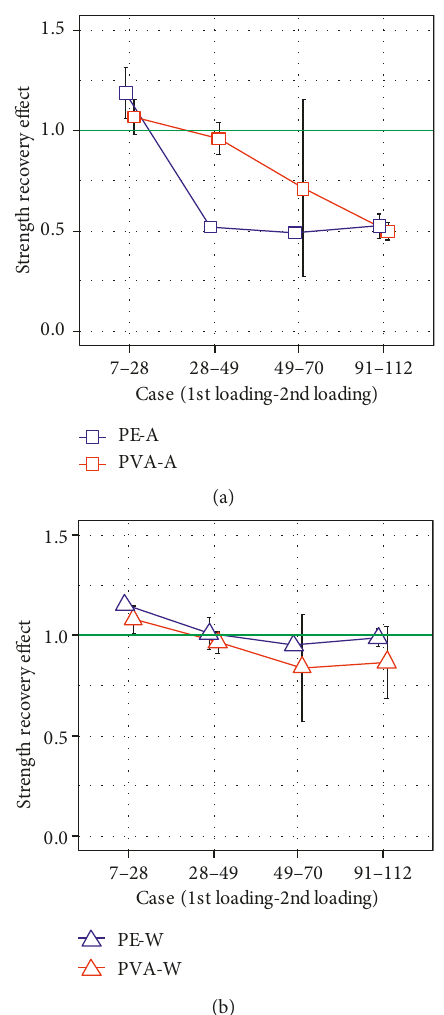
Figure 8: Strength recovery effect: (a) air environment; (b) water